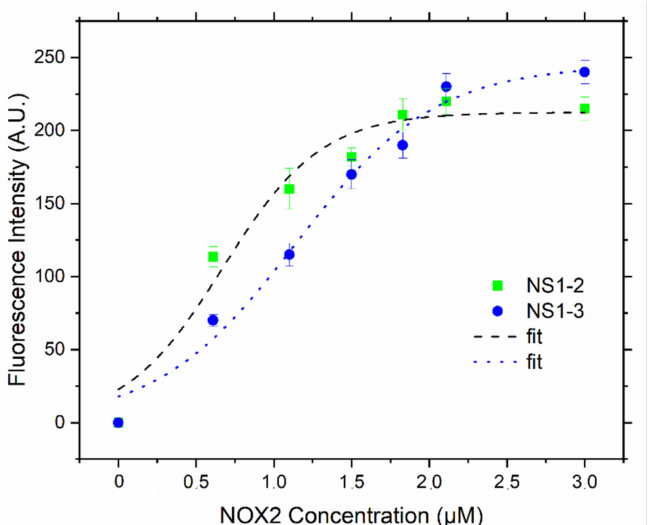
Figure 1. Fluorescence enhancement of NS1-2 and NS1-3 upon binding to recombinant NOX2 C- terminal; the protein was complemented with FAD (at 1/1 ratio), Excitation at 460 nm, emission recorded in the range 480–700 nm. A broad maximum emission was detected at (560–580) nm. The data were corrected for the contribution of FAD by subtracting the signal obtained with FAD in buffer at each NOX2 concentration. The data are fitted to a dose–response curve embedded in Origin 8.1 software with the following parameters: NS1-2: A 1 (lower asymptote) = 0, A 2 (upper asymptote) = 212 ± 11, K D = 0.67 ± 0.11 µ M, R 2 = 0.965; NS1-3: A 1 = 0, A 2 = 244 ± 14, K D = 1.14 ± 0.09 µ M, R 2 =